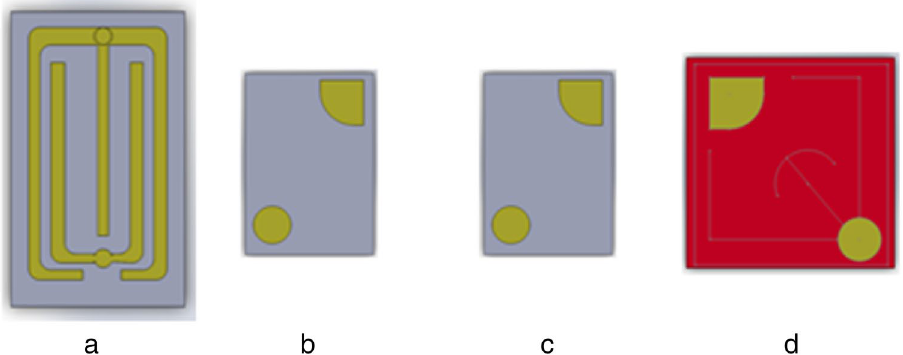
Figure 7. Images of LEDs. ( a ) Blue for lighting. ( b ) Blue for display. ( c ) Green for display. ( d ) Red for